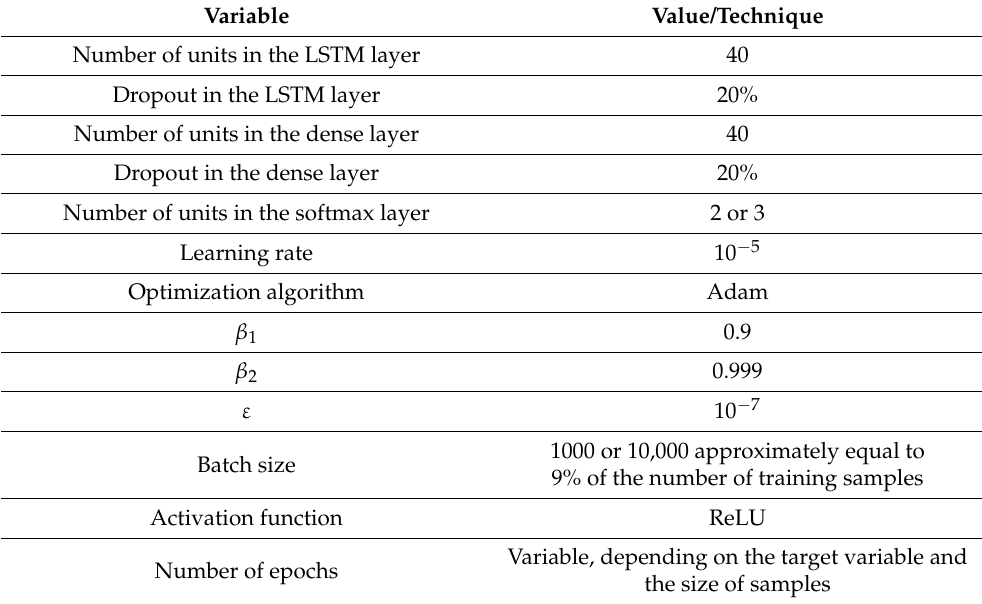
Table 4. The value of adjustable parameters used in the LSTM RNN models